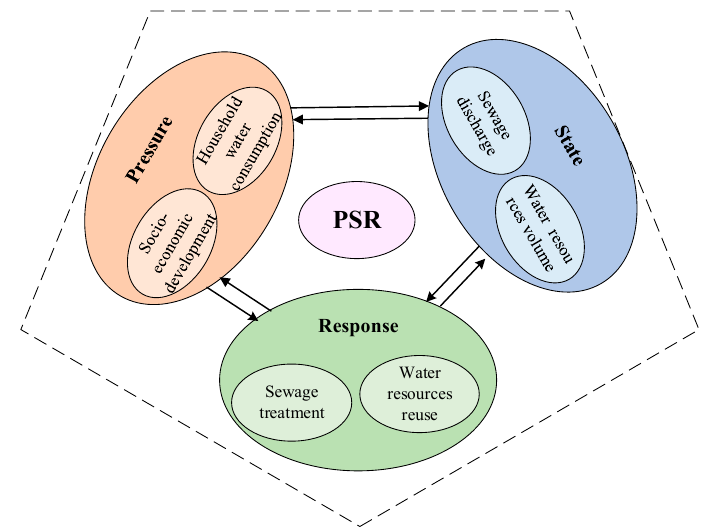
Figure 3. The PSR framework of reflecting the causes, consequences, and responses of the changes in the water ecosystem.